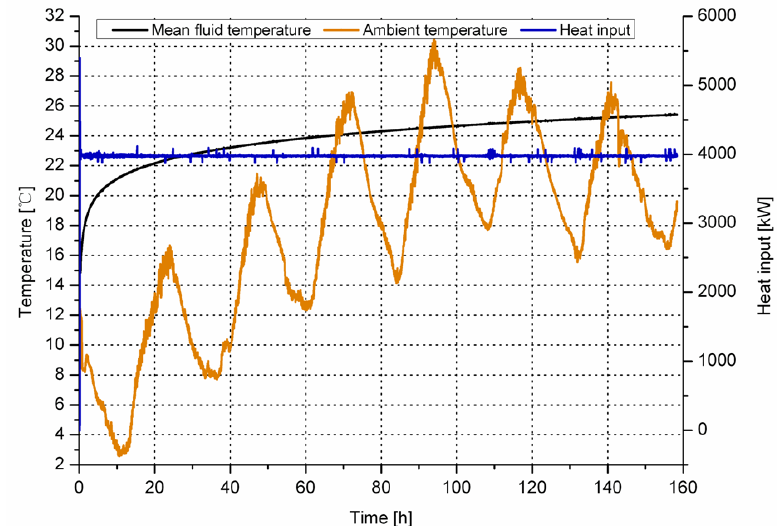
Figure 1. Recording of the TRT test performed in the drillhole of 121 mm diameter. The TRT tests have been performed separately at the three ensembles of the installed